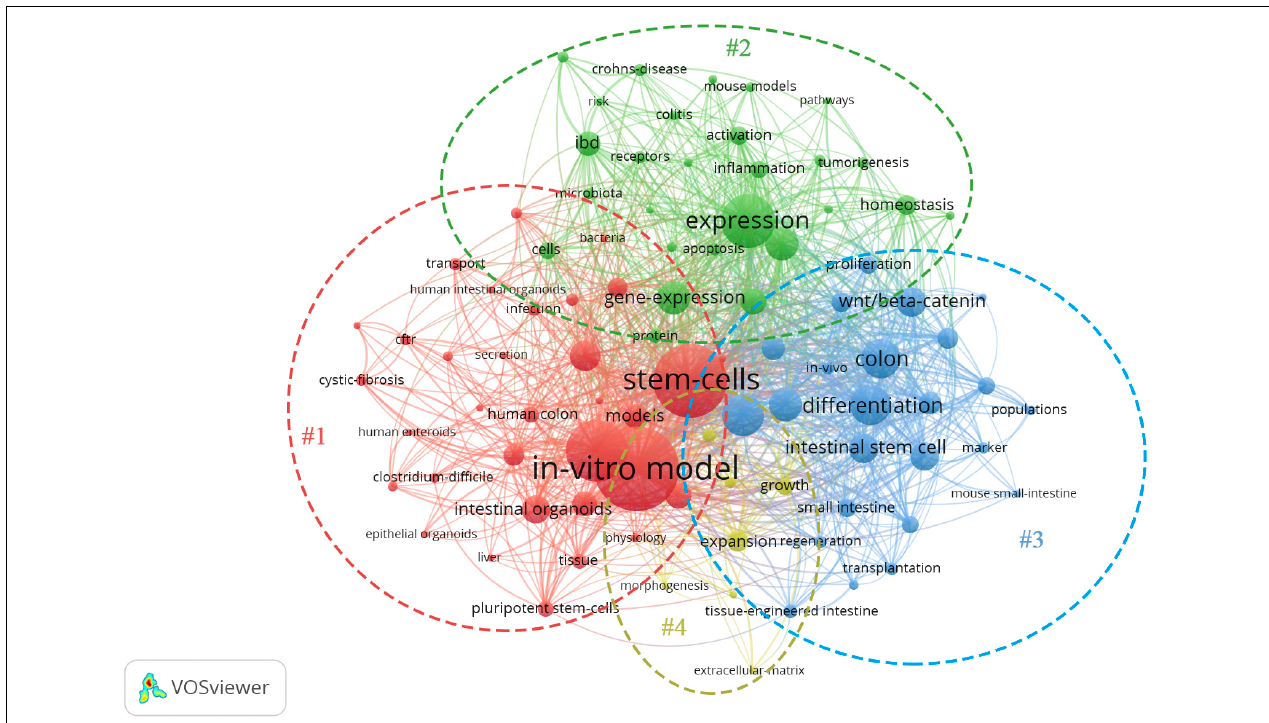
FIGURE 2 | Network map of the high-frequency keywords for IO